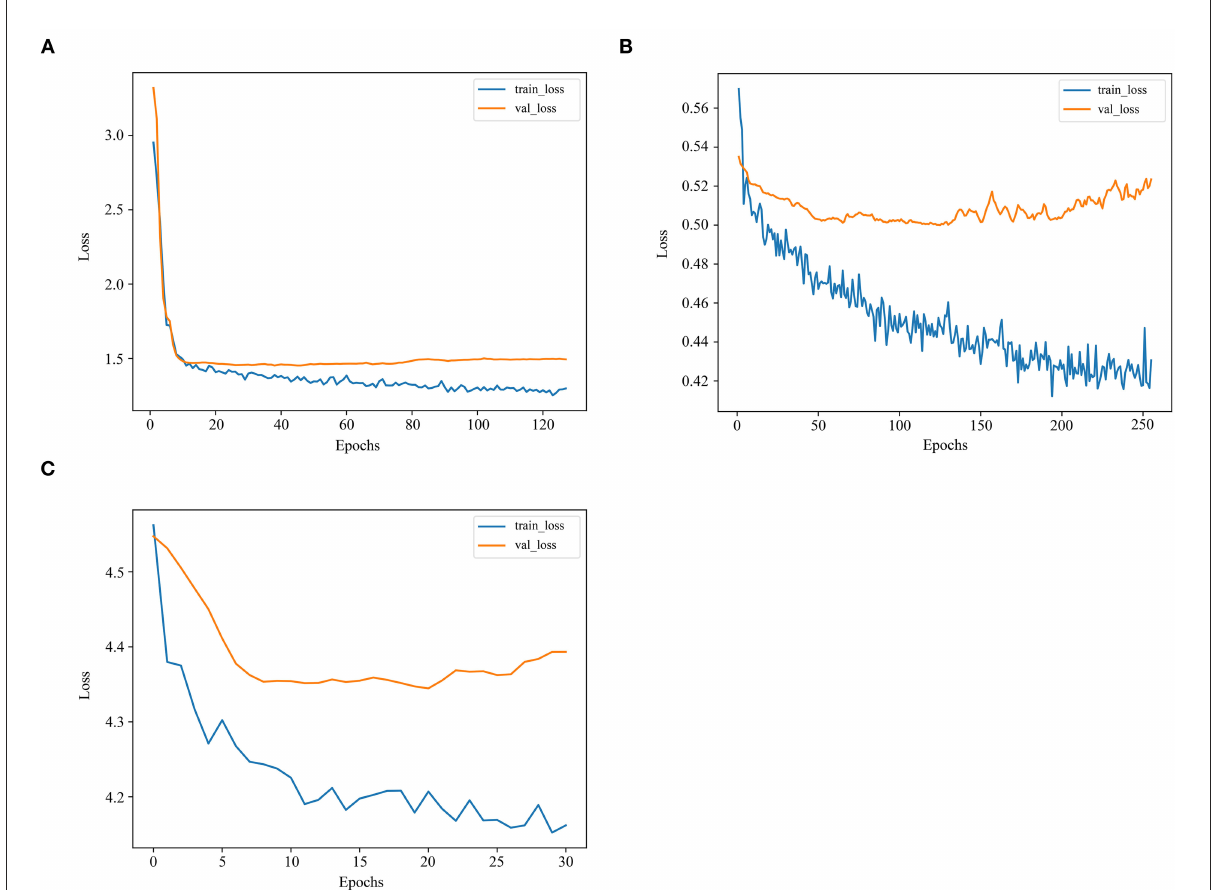
FIGURE4 The losses in the training and validation sets with deep learning models. (A) The losses in the training and validation sets with the LogisticHazard model. (B) The losses in the training and validation sets with the DeepHit model. (C) The losses in the training and validation sets with the DeepSurv